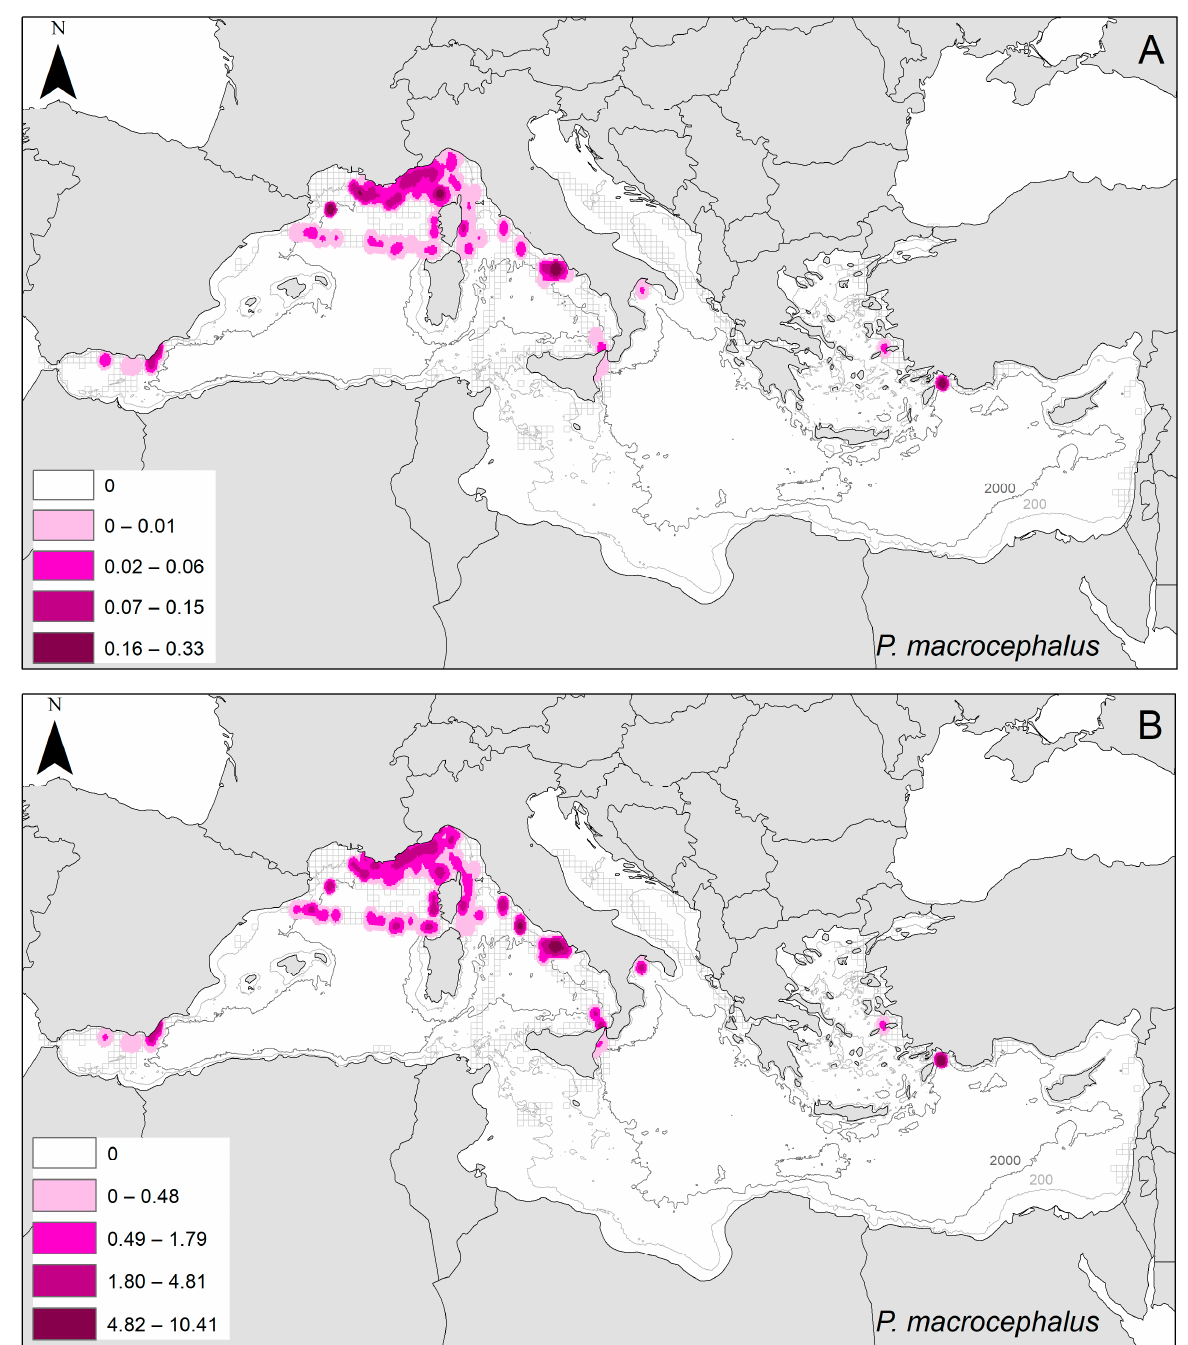
mum in the Alboran Sea, in the central portion of the Pelagos Sanctuary, and in a few relatively small areas such as in the northeast of Sardinia (the so-called canyon system of Caprera, Italy) and in the Bay of Antalya (Türkiye). This species shows a clear preference for waters outside the conti- nental shelf (>200 m) and a slight preference for the waters of the continental slope (200–2000 m). The prevalence map ( B ) confirms this pattern of presence and distribution limited to a few specific areas (Kernel density parameters: cell size x, y = 5 × 5 km; radius ≈ 30 km; criterion for division into classes: natural breaks).